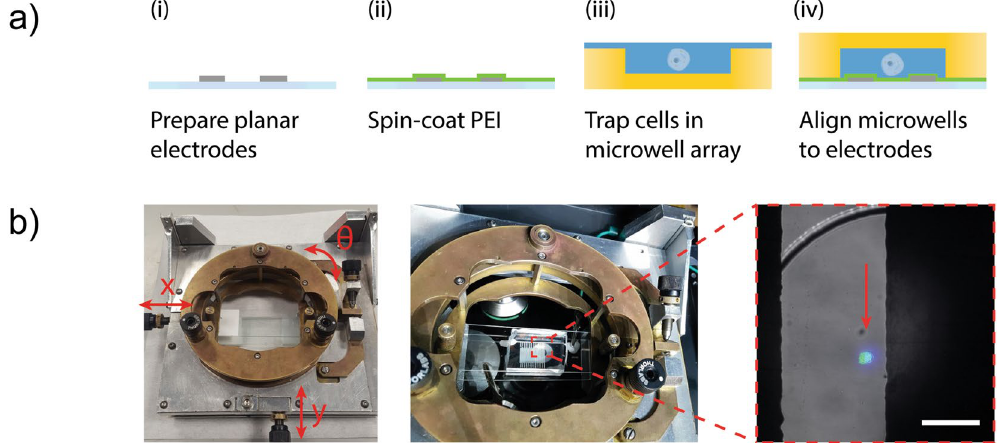
Figure 2. Microwell arrays and patterned electrodes. ( a ) Microelectrodes with an interdigitated geometry are fabricated using the vacuum filling method. A layer of the polymer PEI is spun coat onto the electrodes to promote adhesion and prevent lift-off coating (1% w/v, 2500 rpm). A microwell array (14 × 9; well